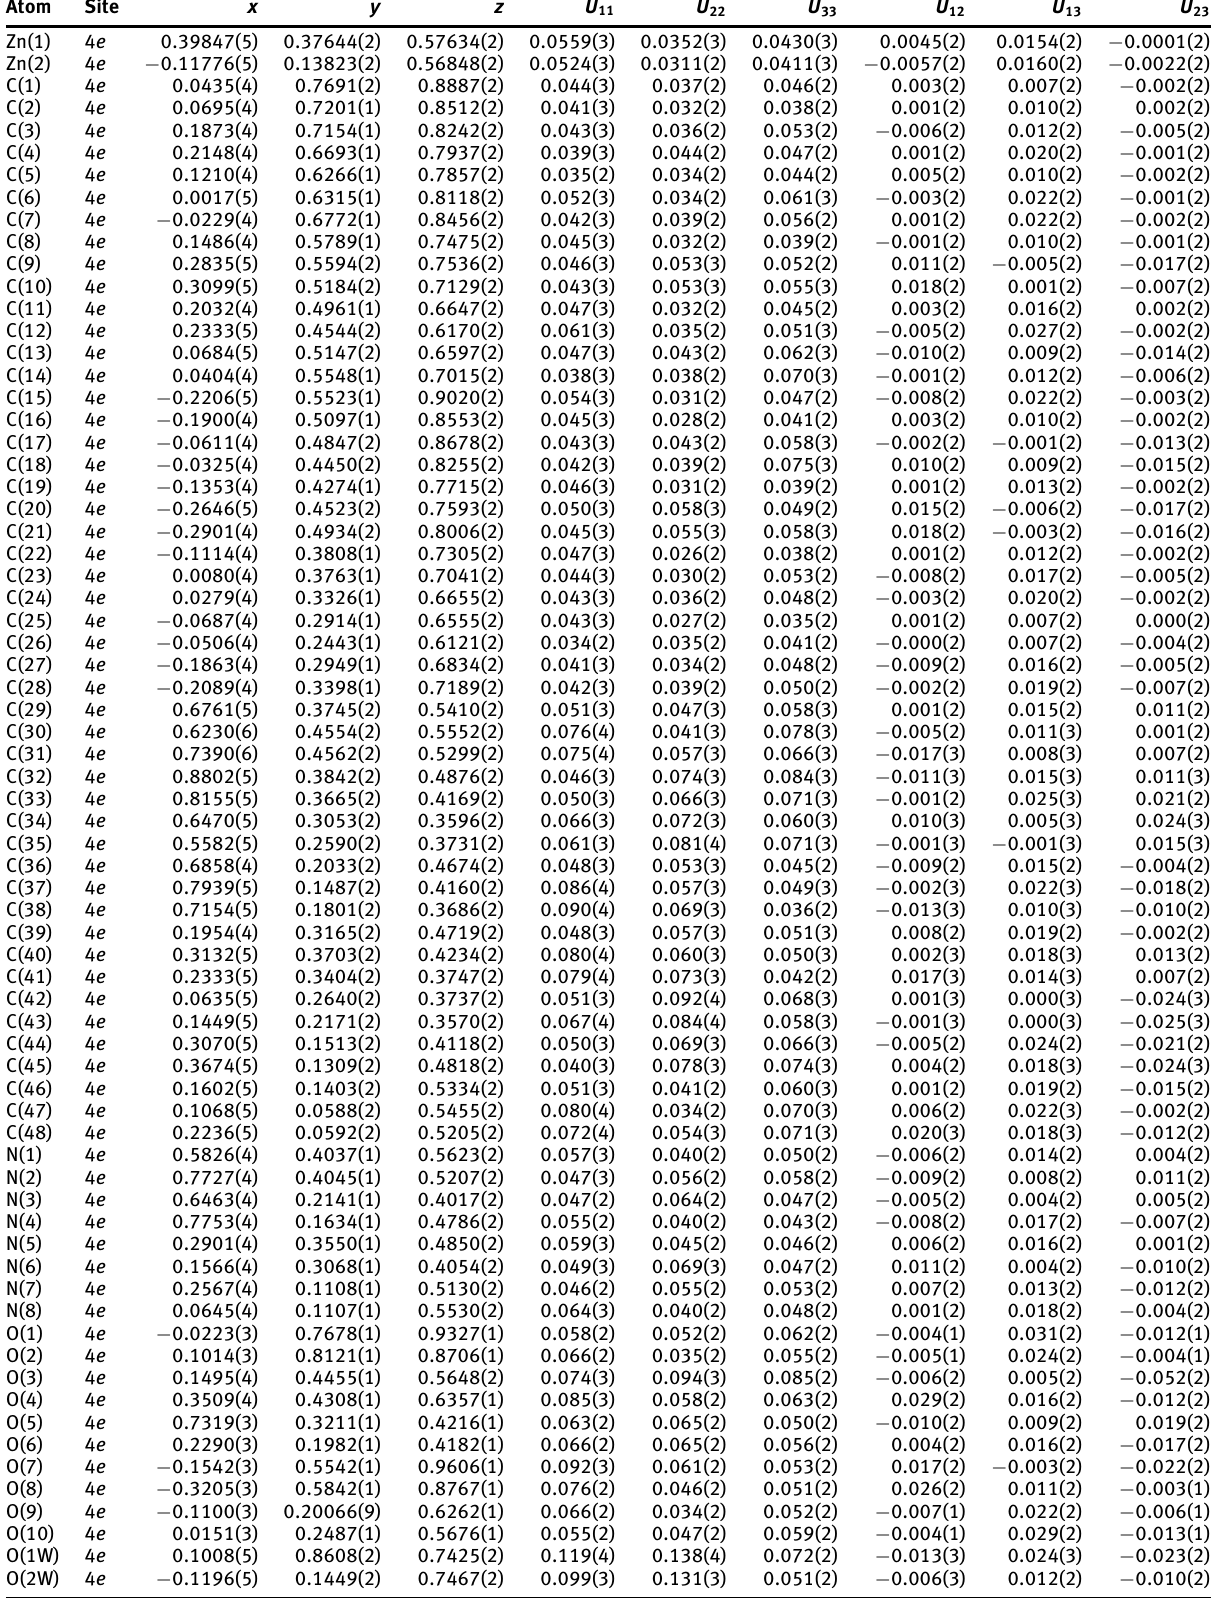
Table 3: Atomic coordinates and displacement parameters (in Å 2